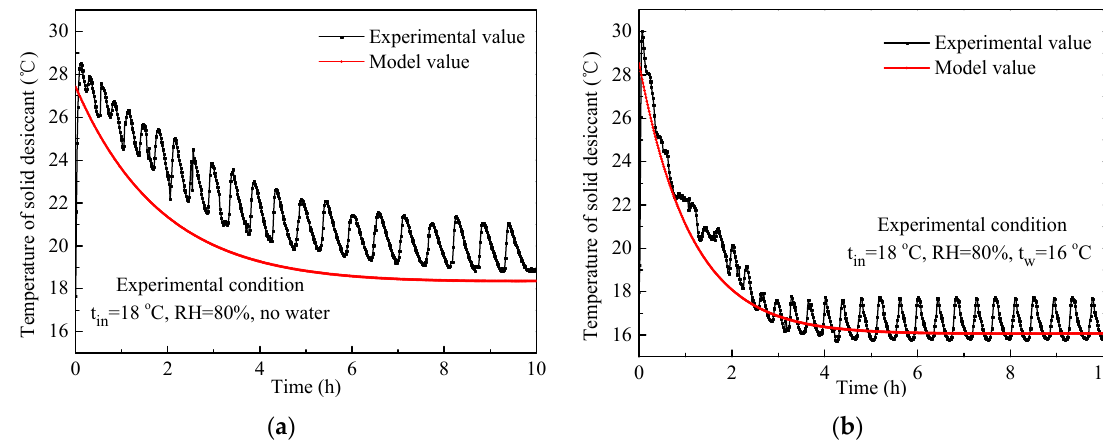
Figure 19. Comparison of results from testing and calculated model on the temperature of solid desiccant: ( a ) without internal cooling; ( b ) with internal